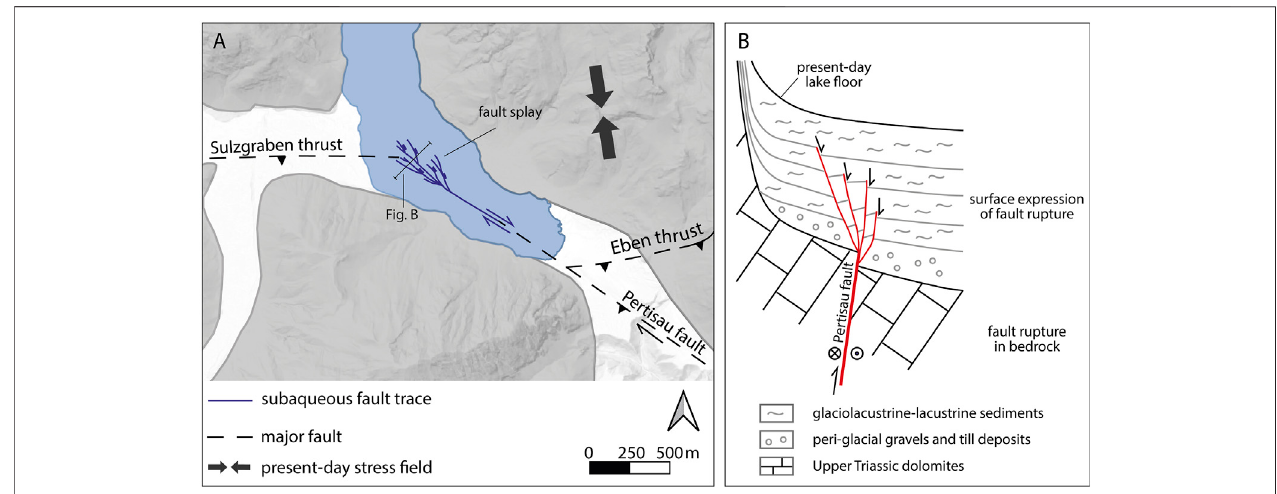
FIGURE 12| Tectonic interpretation of the observed subaqueous fault traces in context with the present-day stress fi eld and adjacent tectonic faults. (A) Adextral transpressive fault motion on the Pertisau fault together with thrusting on one or both of the Sulzgraben- and Eben thrusts is interpreted in the prevalent NNW-SSE compressional stress fi eld. In the overlying lake sediments, this causes a general uplift of the SW block, dominant dextral faulting in the SE part and a fault splay with dominant normal faulting. (B) Sketched, unscaled cross section of the fault splay highlighting the difference of the fault rupture in the bedrock compared to the surface deformation within the water-saturated soft sediments. Note the general uplift of the SW fault block in the bedrock and its corresponding surface expression as normal faulting within the lake sediments near the NW end of subaqueous faults. For location of cross section see A).